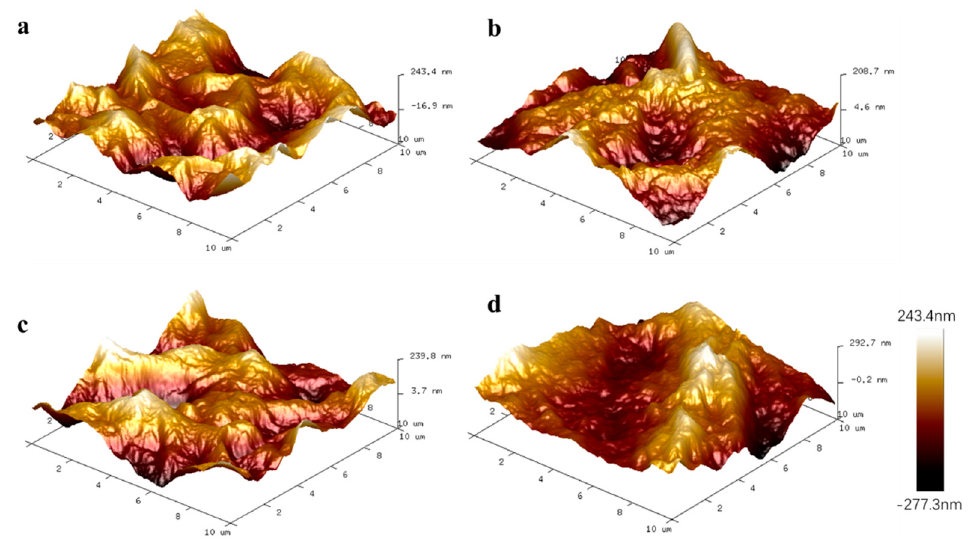
Figure 5. The Atomic force microscopy (AFM) images of surface GOM ( a ), GO-Ala ( b ), GO-Ser ( c ), and GO-PHE ( d ).